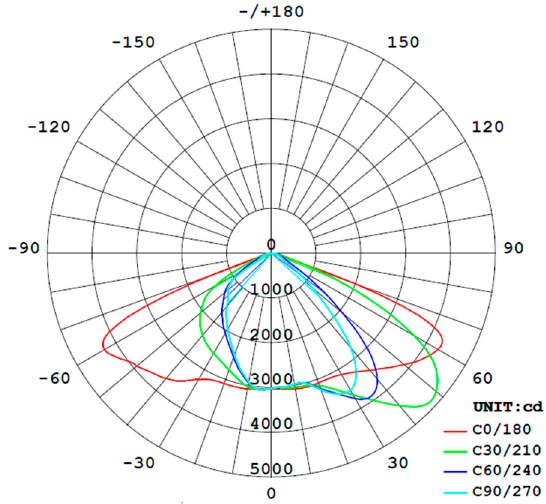
Figure 3. Light distribution curve of LED lamps.